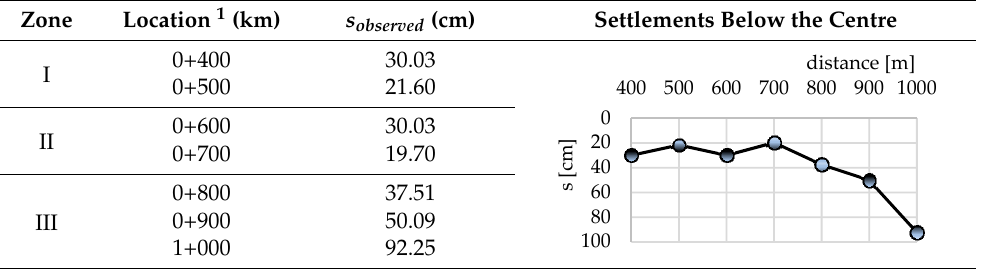
Figure 6. Results sheet of settlements calculation, below the centre (test point 1+000).